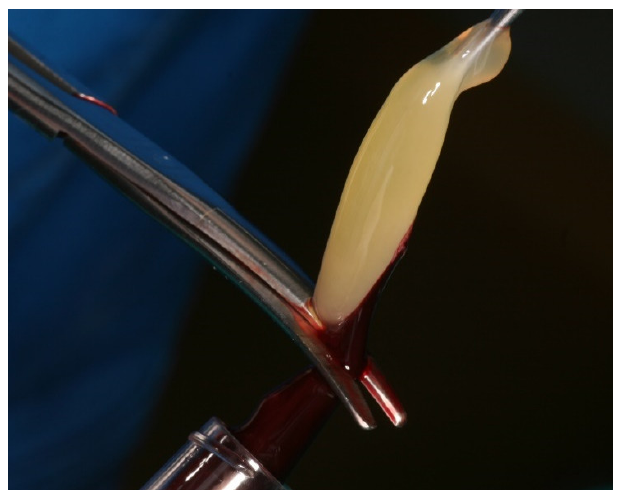
Figure 2. Separation of the PRF fibrin product from the red blood clot.